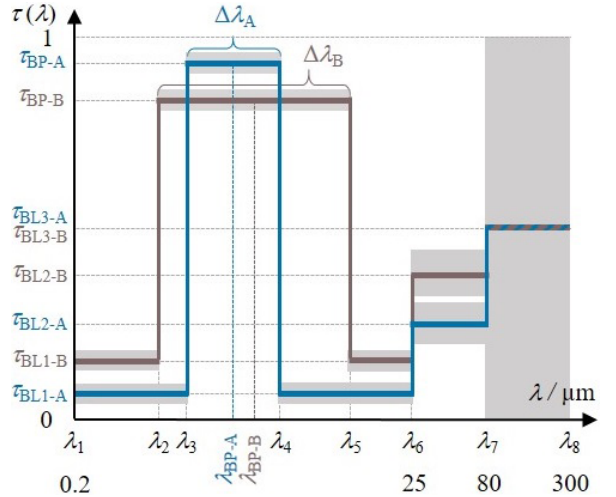
Figure 5. Parametrization of the transmittances of the filters A and B including their uncertainties in different spectral ranges (grey) for the consideration of the transmittance measurements in the calculation of the measurement uncertainty of the spectral re-